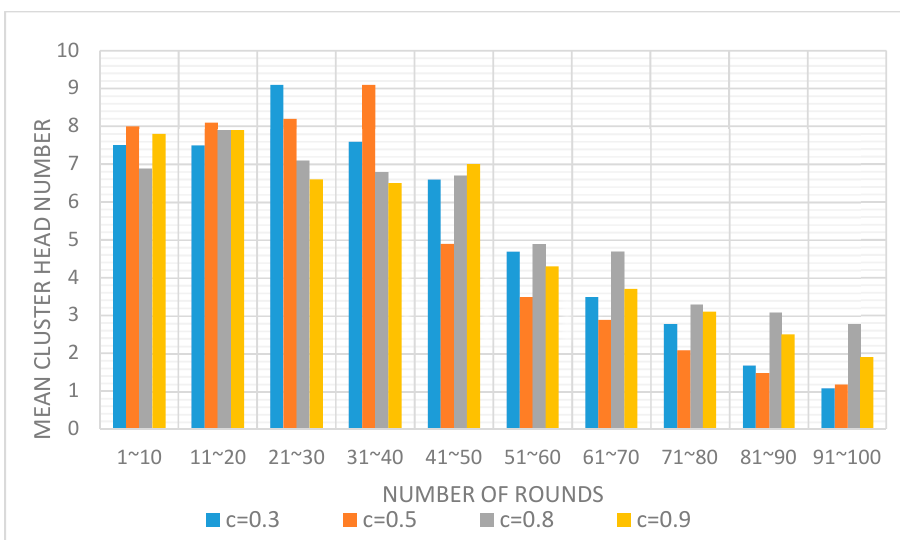
Figure 5. Number of elected CH per 10 rounds, depending on the competition radius calculation.